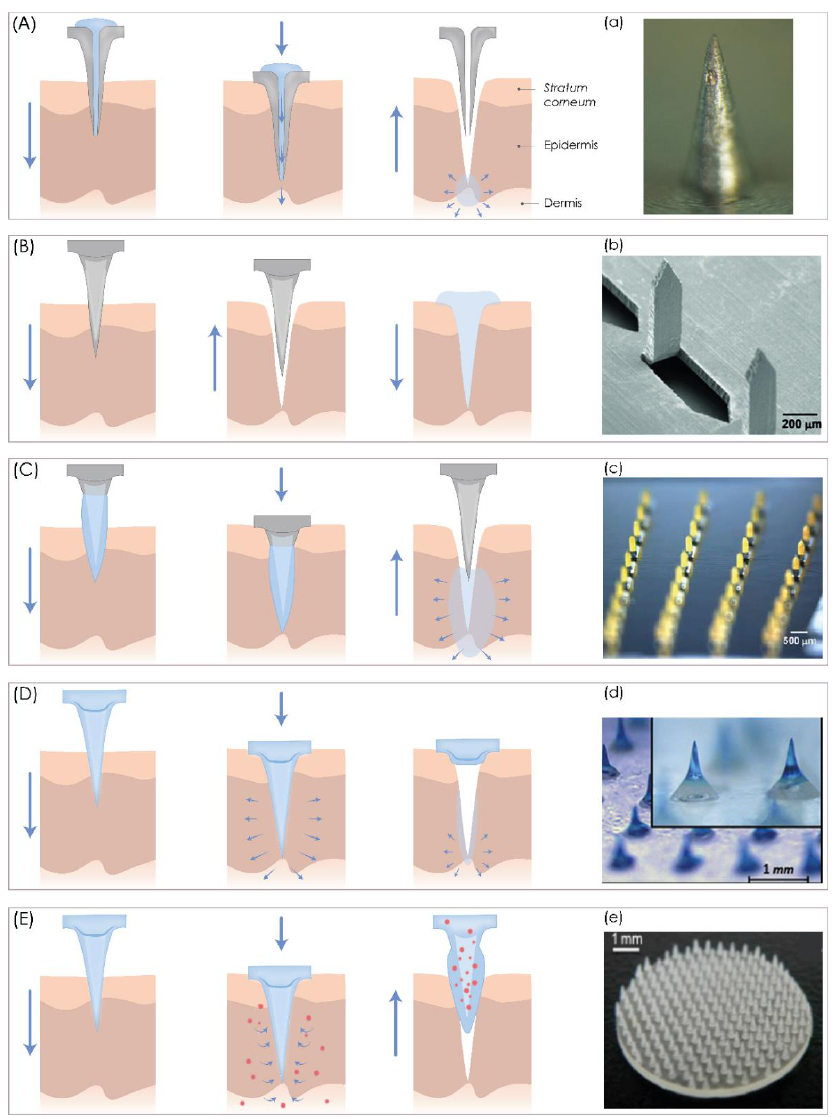
Figure 1. A schematic representation of five different microneedle (MN) types for transdermal drug delivery. ( A ) Hollow MNs puncture the skin and release a liquid drug formulation through the needle lumen. ( B ) Solid MNs create microchannels in the skin and increase drug permeability. ( C ) Coated MNs enable drug dissolution into the skin from the coating film. ( D ) Dissolving MNs release the drug incorporated within the MNs. ( E ) Hydrogel MNs collect interstitial fluids and induce drug release through the swollen microprojections. ( a ) Bright-field microscopy (SZX 16, Olympus, Center Valley, PA, USA) image of hollow MNs. Reproduced with the permission from [80], Springer Nature, 2013. ( b ) SEM microscopy of solid MNs. Reproduced with the permission from [81], Elsevier, Amsterdam, The Netherlands, 2011. ( c ) bright-field microscopy (Olympus SZX12 stereo microscope, Olympus America) image of coated MNs. Reproduced with the permission from [37], Springer Nature, 2007. ( d ) microscope (STC-GE33A, SENTECH, Yokohama, Japan) image of dissolving MNs. Reproduced with the permission from [82], Elsevier, 2013. ( e ) picture of a hydrogel microneedle patch. Reproduced with the permission from [83], John Wiley & Sons—Books, 2015. The image was created with Adobe Illustrator CC (Version 23.0.1.; Adobe Inc., San Jose, CA,